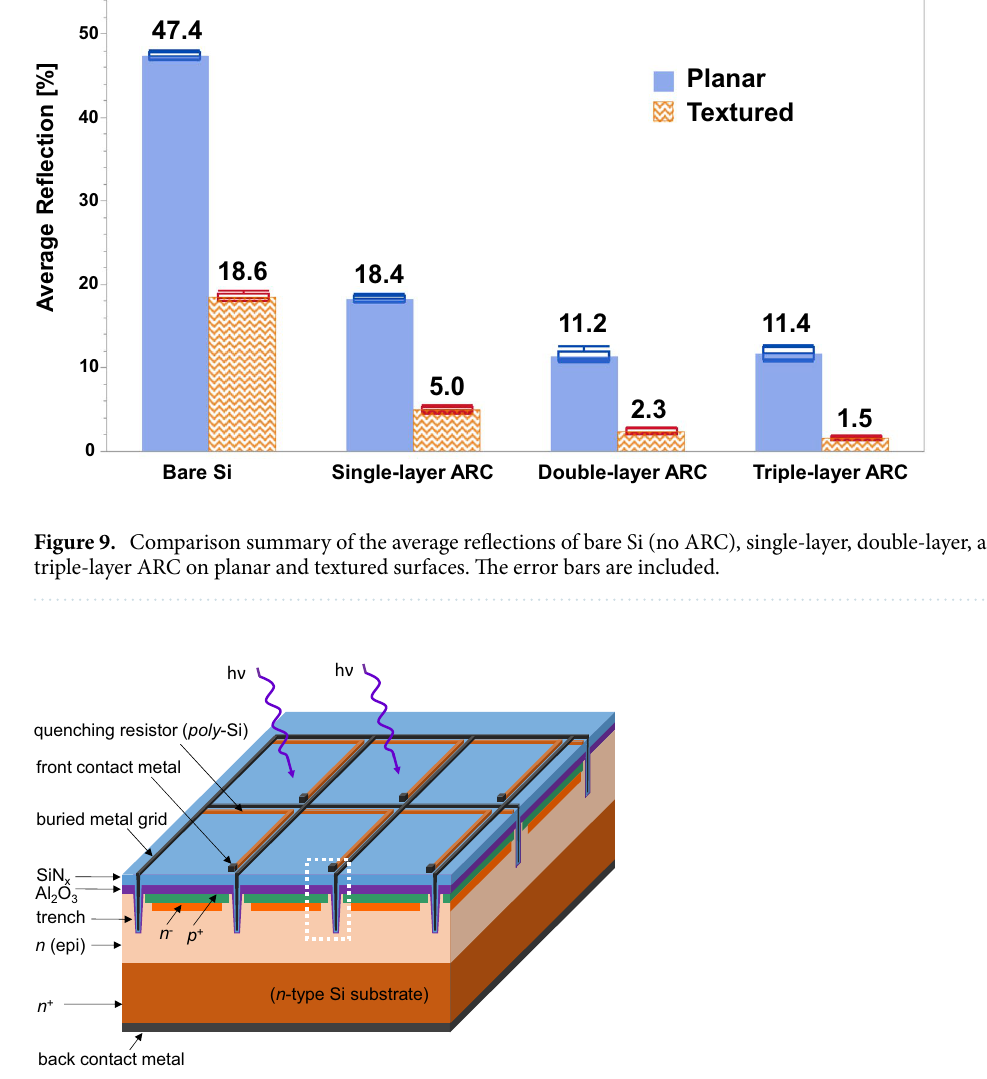
Figure 10. Schematic of conventional front-illuminated SiPM with SiN x as single-layer ARC on planar surface. The section highlighted by the dash-line rectangle is enlarged and shown in the left part of Fig.